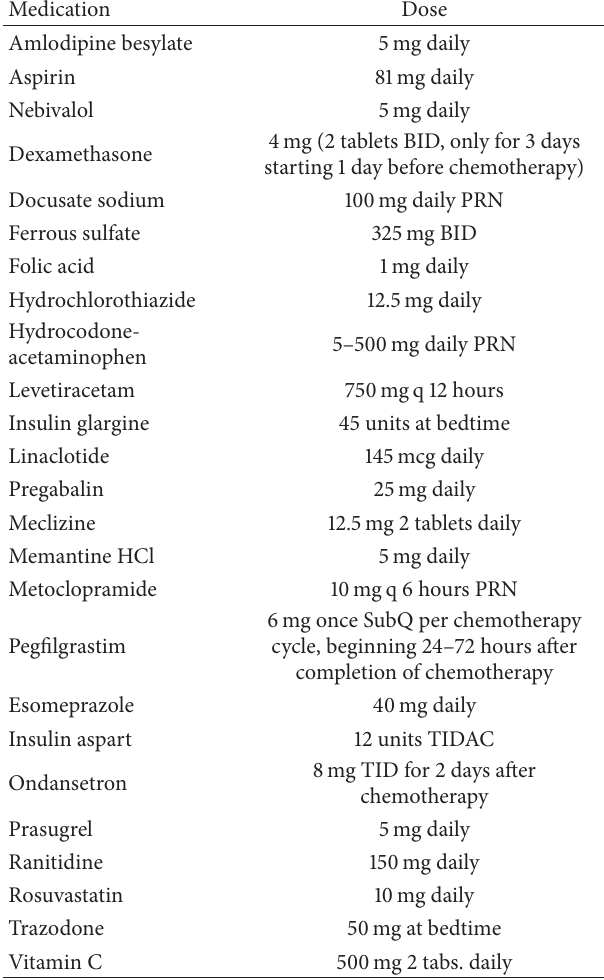
Table 1: Home medications.